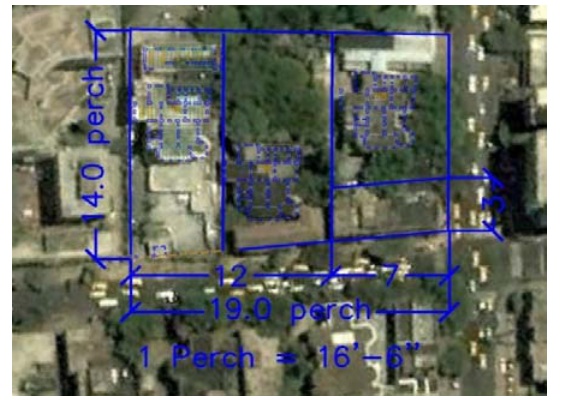
Figure 4: The 2016 map of park street kolkata